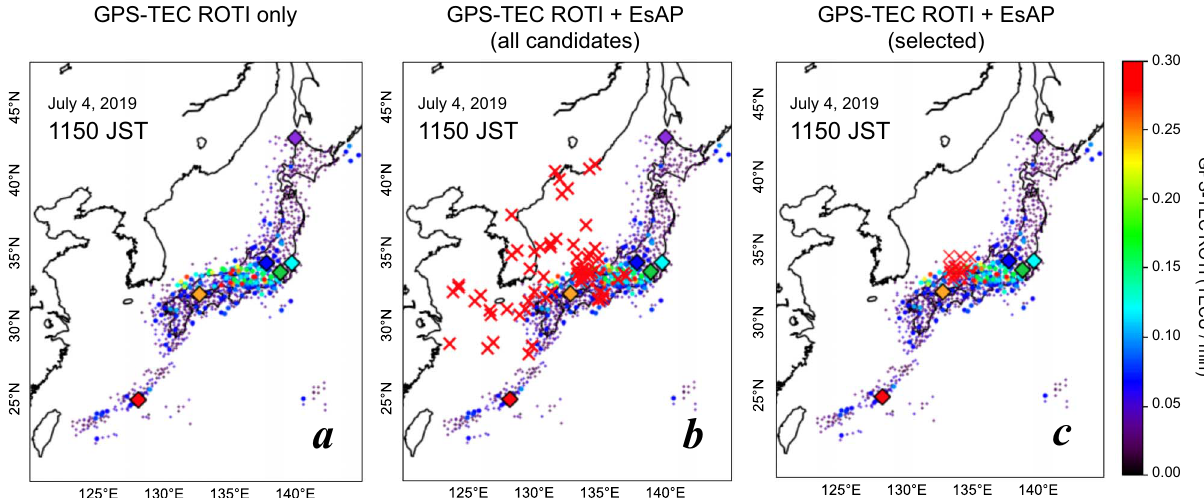
Fig. 3. (a) Map of ROTI at 1150 JST on July 4, 2019, which have been mapped onto an altitude of 100 km. The diamonds show the locations of the six Rx stations of NAV signals (purple = Sarobetsu, light blue = Oarai, green = Chofu, blue = Sugadaira, orange = Kure, and red = Onna). (b) Distribution of all the possible re fl ection points of EsAPs detected at the six Rx stations. The red cross marks represent the re fl ection points, which have been superimposed on ROTI map. (c) Same data as (b), but imaginary re fl ection points are fi ltered